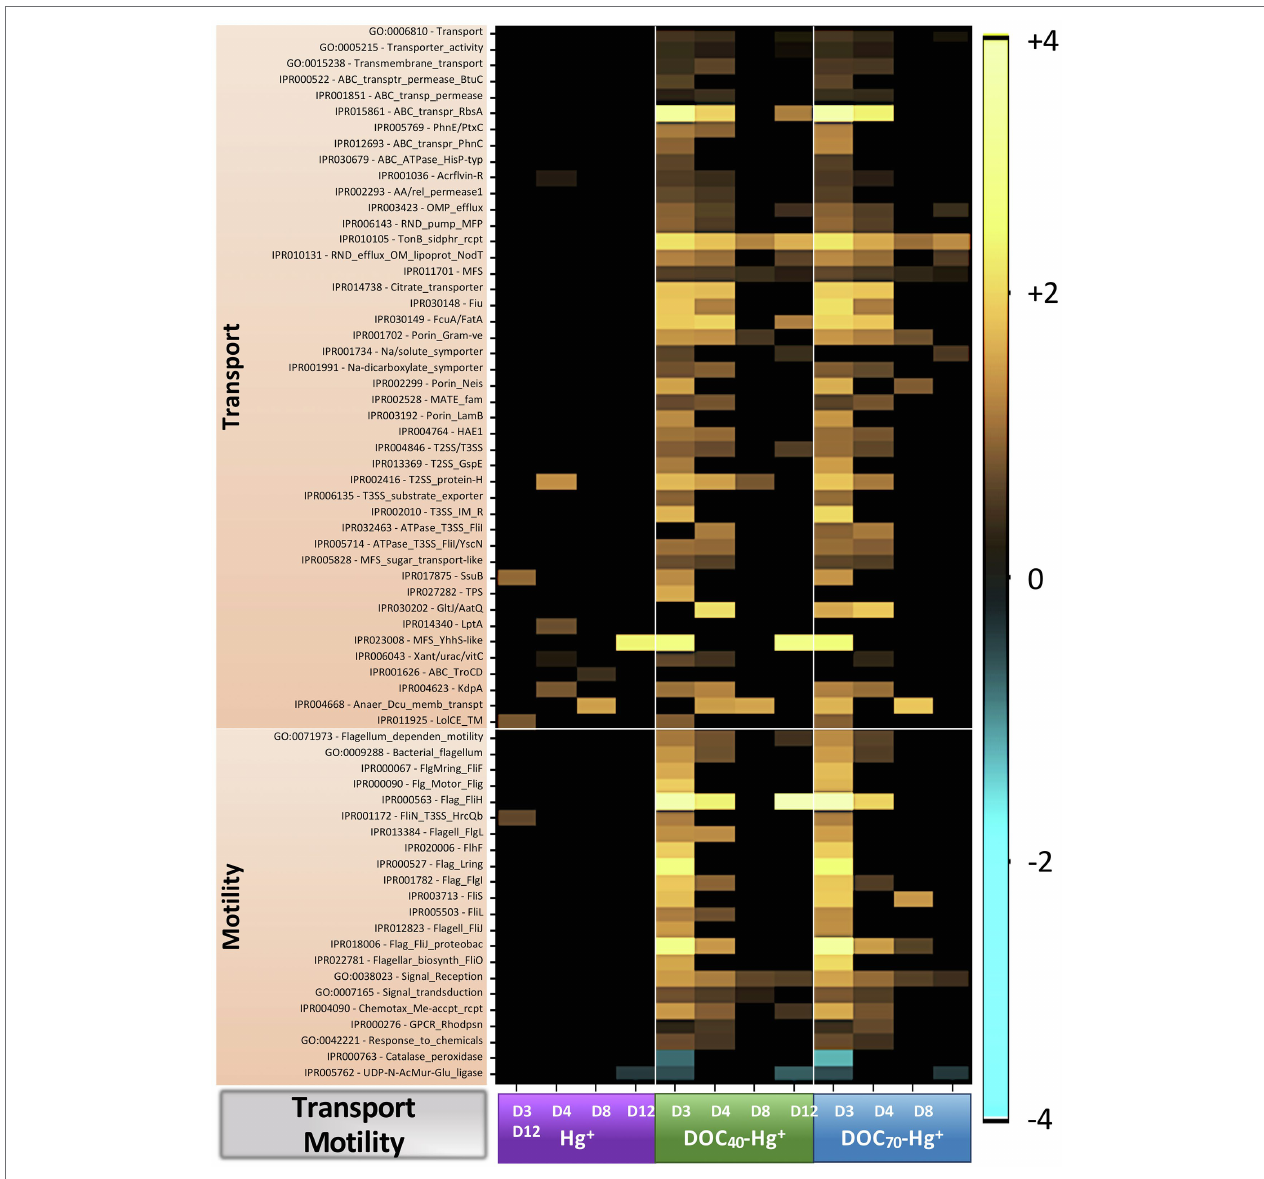
FIGURE 7 | Heatmap showing Log2 fold-change abundance of functional genes involved in transport of molecules and cell motility from treatments Hg + , DOC 40 - Hg + , and DOC 70 -Hg + compared to the unexposed control. Warm colors (yellow) indicate overrepresentation (i.e., higher abundances), colder colors indicate underrepresentation, and black indicates non-significance ( p >